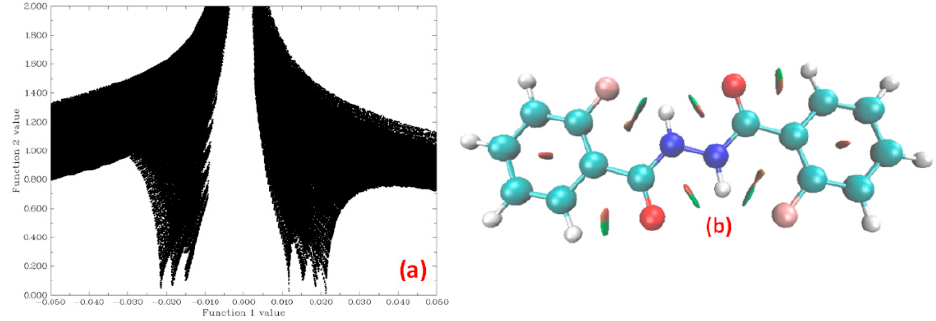
Figure 18. ( a ) The plot of sign( λ 2(r) )* ρ (r) as function 1 v/s the RDG as function 2; and ( b ) coloured isosurface plot (green color denotes weak H-bond and red color stands for steric effect) for molecule 9 .